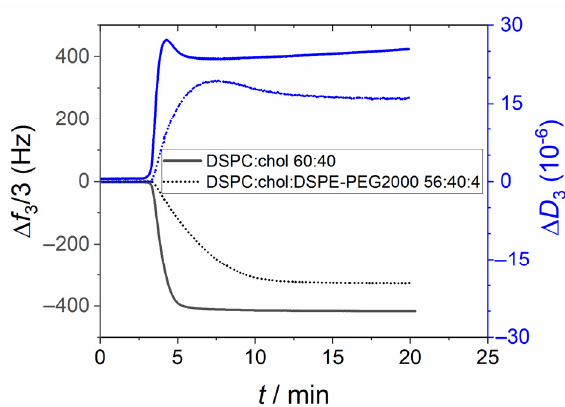
Figure 16. QCM-D signals (3rd overtone) obtained from the adhesion, of DSPC:cholesterol (60:40 moL%—solid line) and DSPC:cholesterol:DSPE-PEG2000 (56:40:4 moL%—dotted line) liposomes on a silica surface at 21 °C.